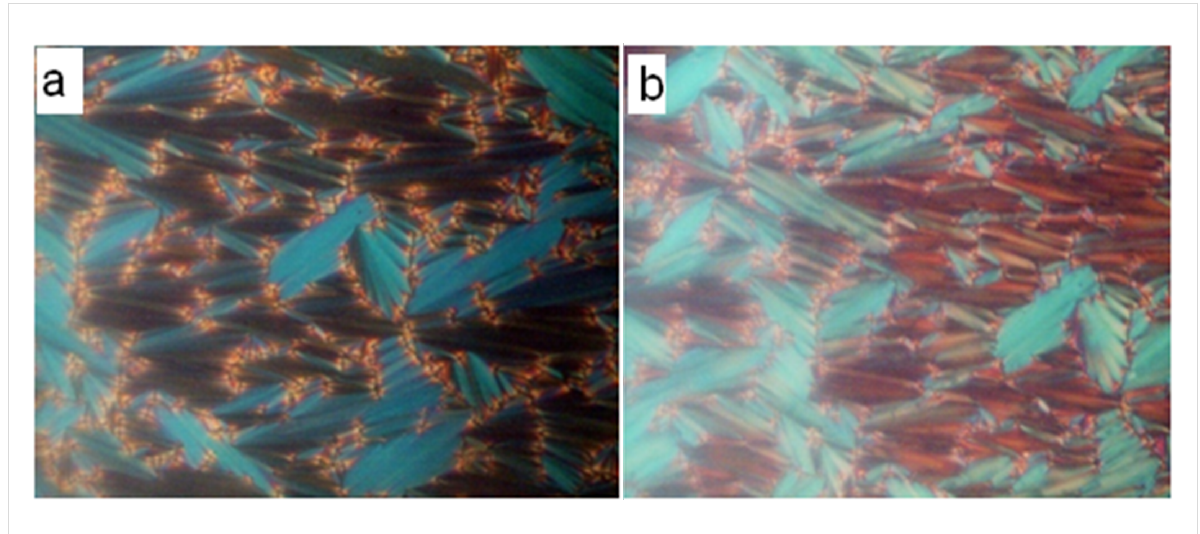
Figure 1: (a) Focal conic fan texture exhibited by 13ar (Ph.Ox.C*C 10 ) at 120 °C. (b) Broken focal conic fan texture exhibited by 13br (C 12 .Ox.C*C 10 ) at 65 °C.